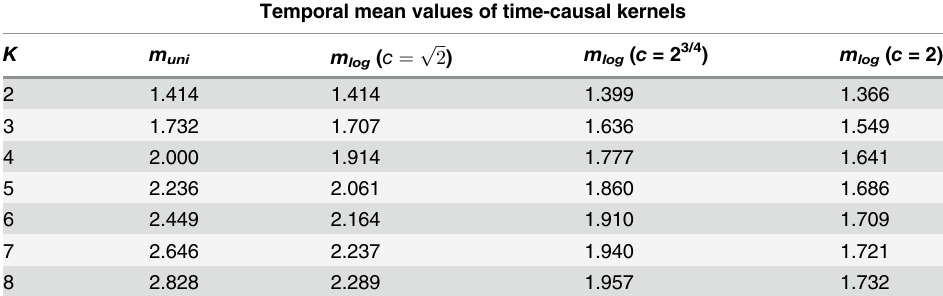
Table 2. Numerical values of the temporal delay in terms of the temporal mean m ¼ ffiffiffiffi p s ¼ t for time-causal kernels obtained by coupling K truncated exponential kernels in cascade in the cases of a uniform distribution of the intermediate temporal scale levels τ k = k τ / K or a logarithmic distribution τ k = c 2( k − K ) τ with c >